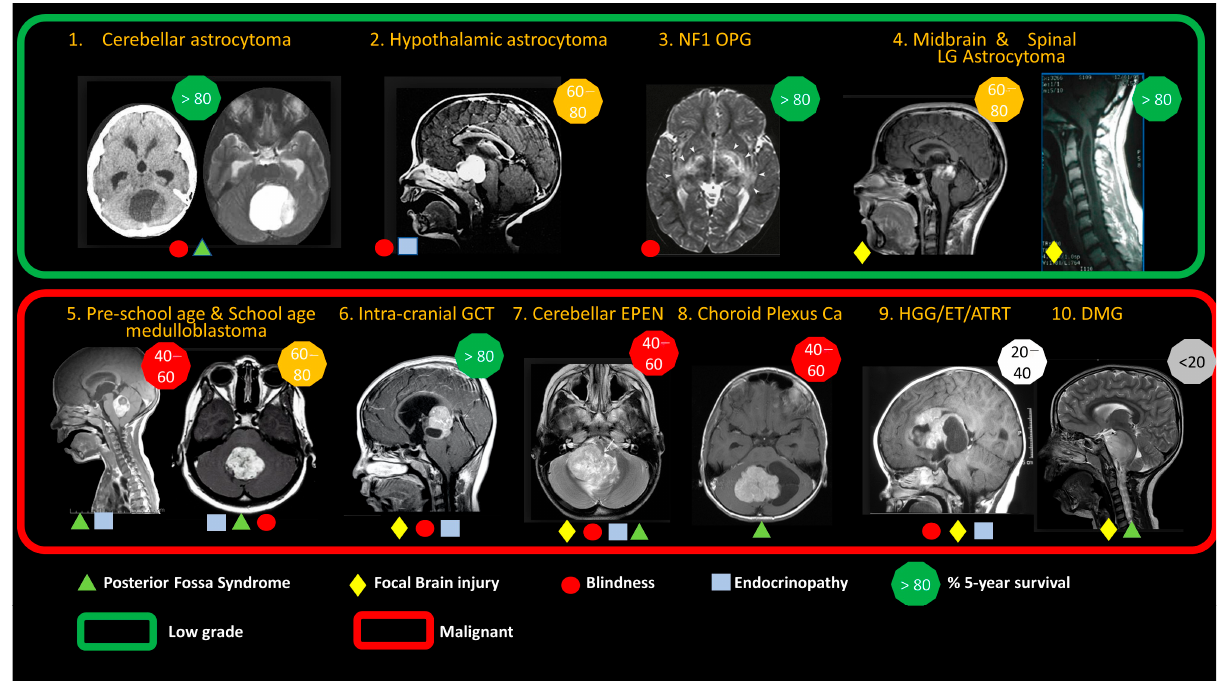
Figure 1. Anatomical features of ten common brain tumors in children, highlighting the predomi- nance of low-grade glioma (green box) and range of malignant tumor types (red box). Low-grade tumors account for ~40% of all childhood brain tumors, are slow-growing and have a very low risk of metastasis. Malignant tumors are fast-growing and have a higher risk of metastasis. Symbols illustrate typical late consequences of the tumor and its treatment, for survivors. Posterior fossa syndrome refers to motor, cognitive and speech consequences of cerebellar mutism syndrome, brainstem damage and prolonged hydrocephalus. Focal injury refers to the risk of other regional focal brain injuries related to tumor growth/invasion of brain structures or the consequences of surgery. Blindness is a consequence of tumor damage to optic nerves, chiasm and tracts or prolonged raised intracranial pressure. Endocrinopathy is due to hypothalamic/pituitary damage from tumor, surgery or radiation therapy to these regions of the brain. The figures illustrate typical population-based 5-year survival rates. See Table S1 for a more detailed description of molecular factors and prognostic criteria. Abbreviations: NF1 OPG, neurofibromatosis type I optic pathway glioma; LG, low-grade; MB, medulloblastoma; GCT, germ cell tumor (germinomatous/non-germinomatous); EPEN, ependy- moma; Ca, carcinoma; HGG, high-grade glioma; ET, embryonal tumor; ATRT, atypical teratoid rhabdoid tumor; DMG: diffuse midline glioma. Figure reprinted with permission from textbook “ Brain and Spinal Tumors of Childhood ” under a PLSclear FPL License; Informa UK Limited License No.